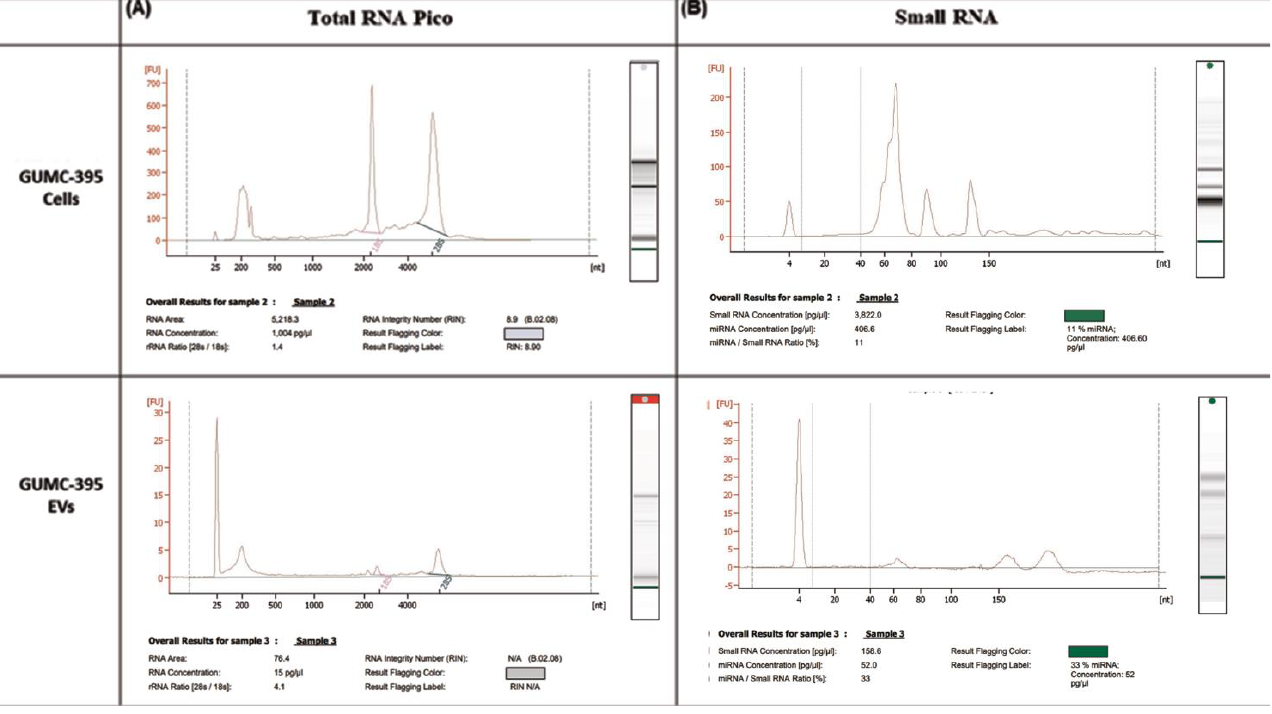
Figure 3. Characterisation of RNA extracted from GUMC-395 cells and their EVs. RNA quality was evaluated using ( A ) RNA 6000 Pico kit and ( B ) small RNA kit from Agilent Bioanalyser for GUMC-395 cells and their EVs were extracted using SBI isolation techniques. The x -axis is the size of the RNA, measured in nucleotides (nt), and the y -axis represents fluorescence.